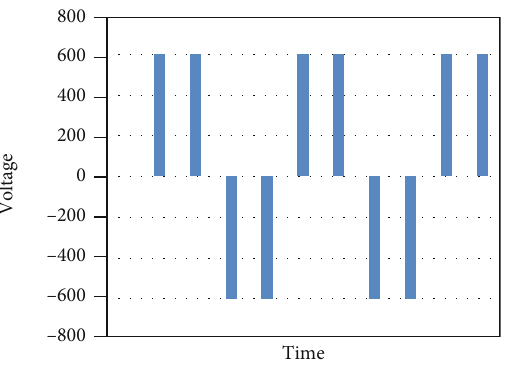
Figure 12: Output voltage of inverter.